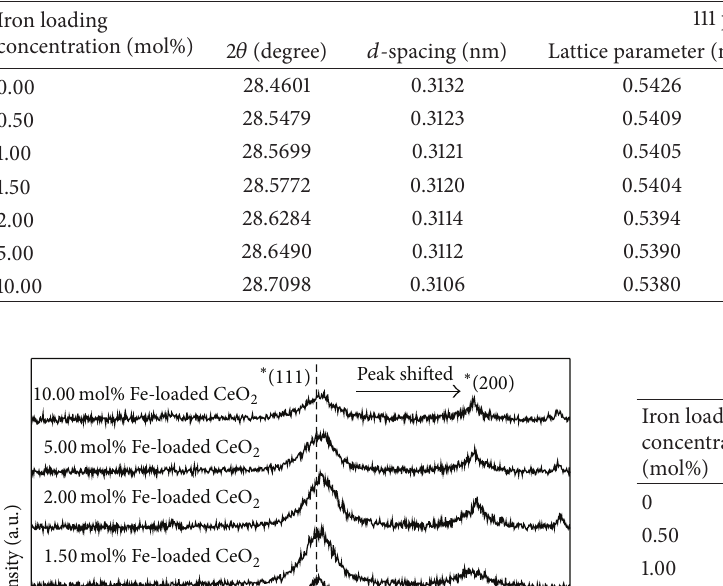
Table 1: The calculated 𝑑 -spacing, lattice parameters, unit cell volume, and crystalline size.